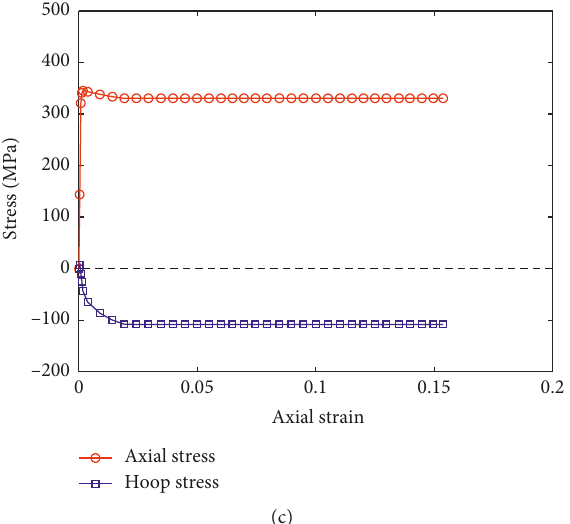
Figure 17: Stresses in the steel tubes of hybrid DTCCs. (a) A4-F80-M1 ( θ � ± 80 ° ; t � 4mm; Type A steel tube). (c) A4-F45-M1 ( θ � ± 45 ° ; t t frp